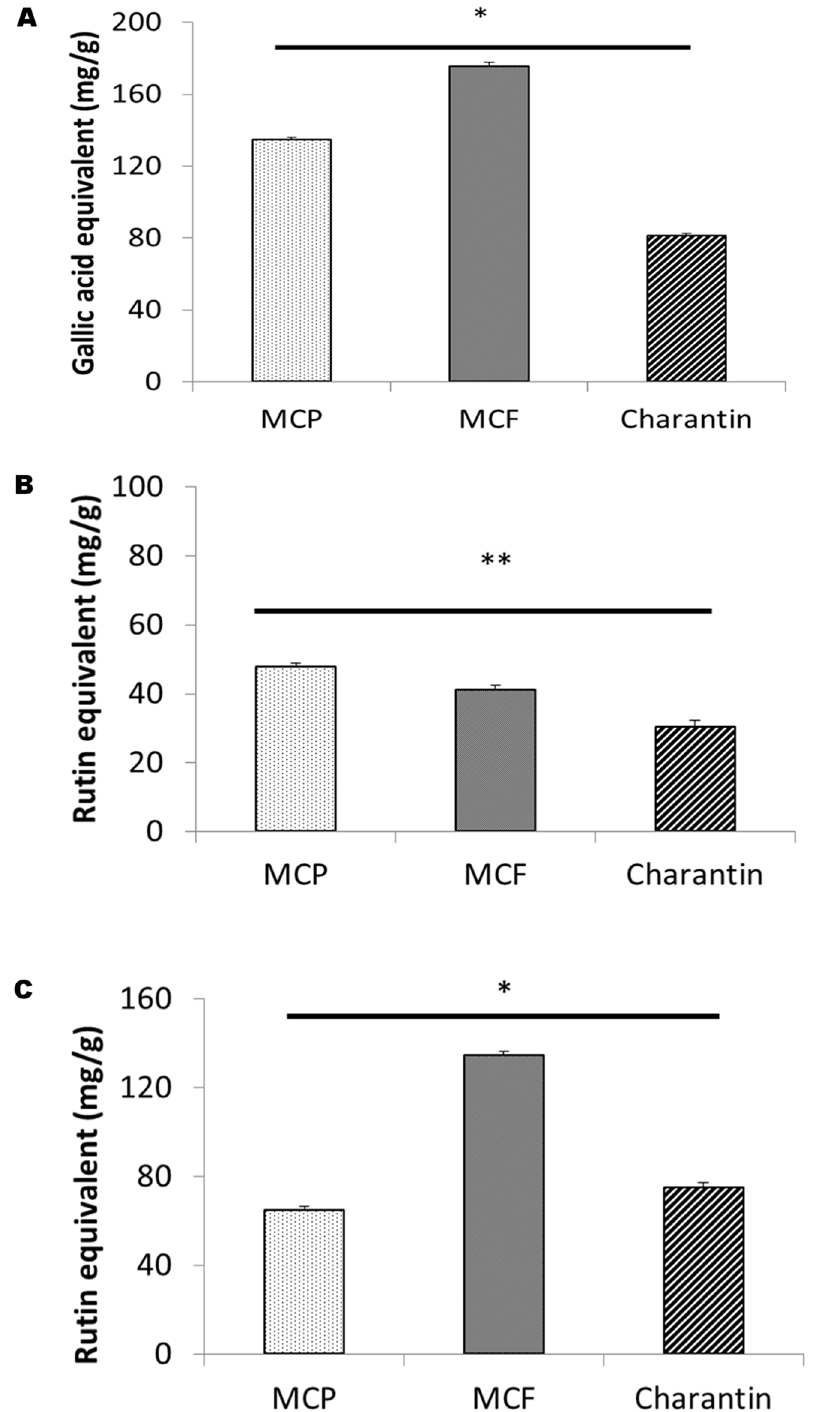
Fig 6. Total phenolic, flavonol and flavonoid contents of 10 mg/ml solutions of MCP, MCF and charantin. (A) phenolic content was determined using the Folin-Ciocalteau method calibrated using gallic acid standards with the results expressed as mg/g of gallic acid equivalents, (B) flavonol content was determined using the AlCl 3 method where the method was calibrated using rutin and results expressed as mg of rutin per g of extract and (C) flavonoid contents of the ethanolic MCP, MCF and charantin extracts determined by a colorimetric method calibrated using rutin and the results expressed as mg of rutin per g of extract. The results are presented as mean ± SD (n = 3). * : p < 0.05, ** : p <